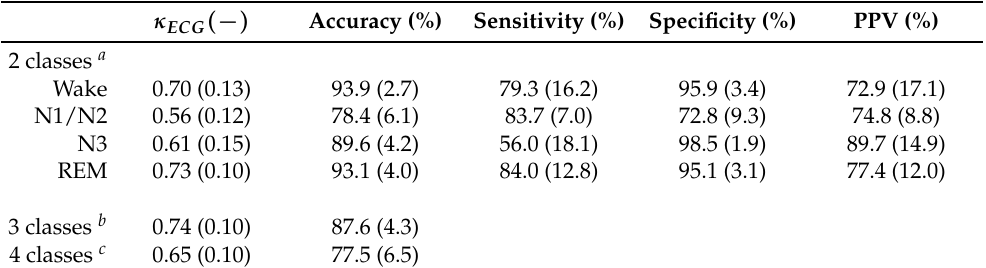
Figure A2. Confusion matrices for ECG versus reference PSG. ( a ) number of epochs, with a total of 34,356 (77%) correctly classified (diagonal, in green); ( b ) sensitivity, relative to ground truth class; ( c ) PPV, positive predictive value, relative to predicted class. Table A2. Classification performance using ECG compared with the reference, i.e., manual scoring. Mean (SD) per